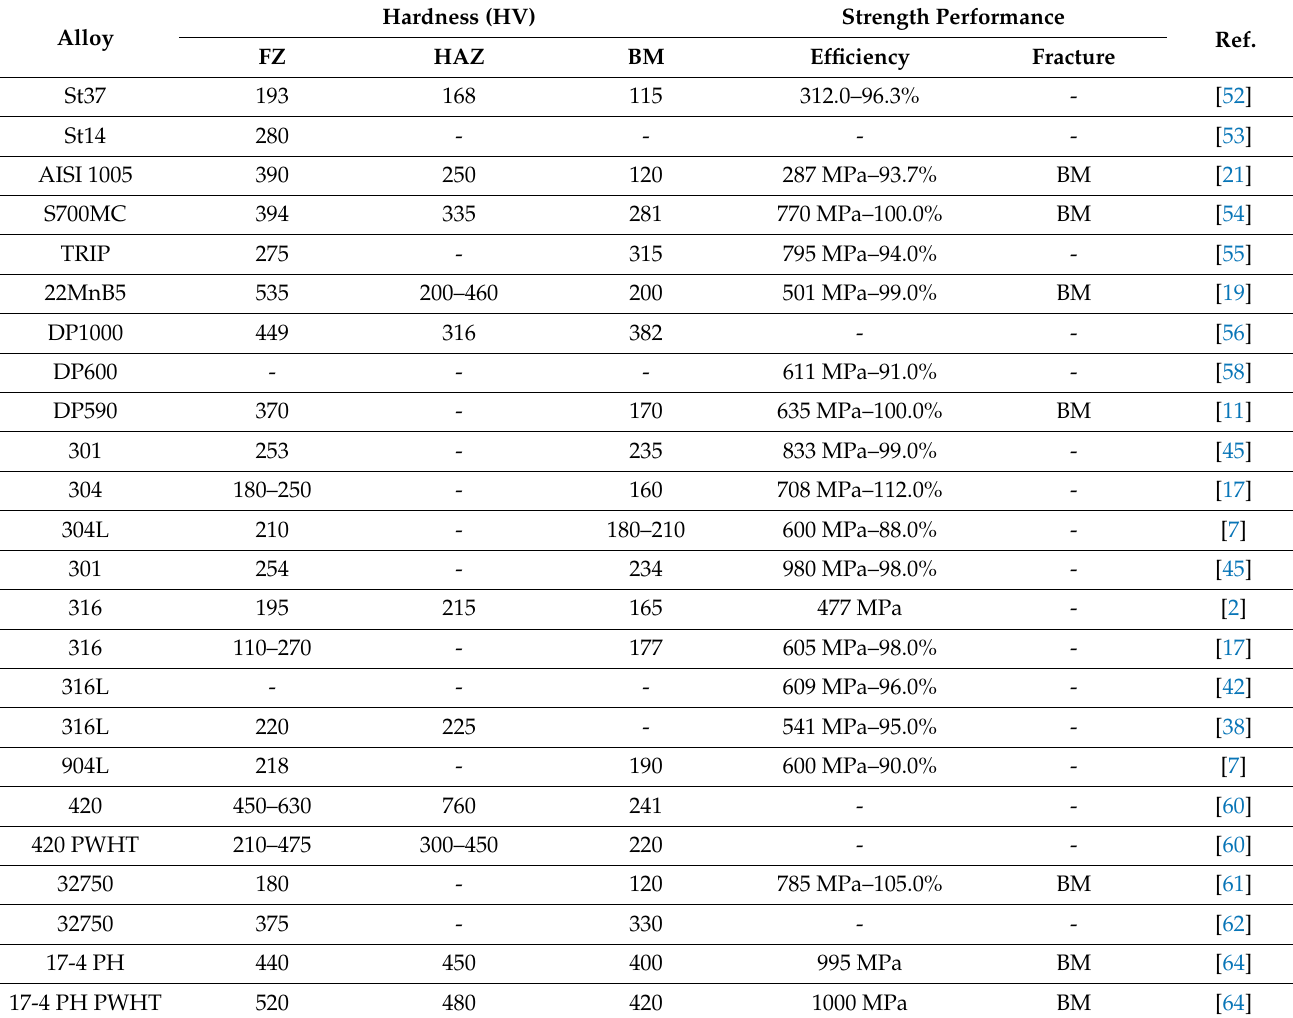
Table 1. Selected results of pulsed laser welding apply to steels (approximated